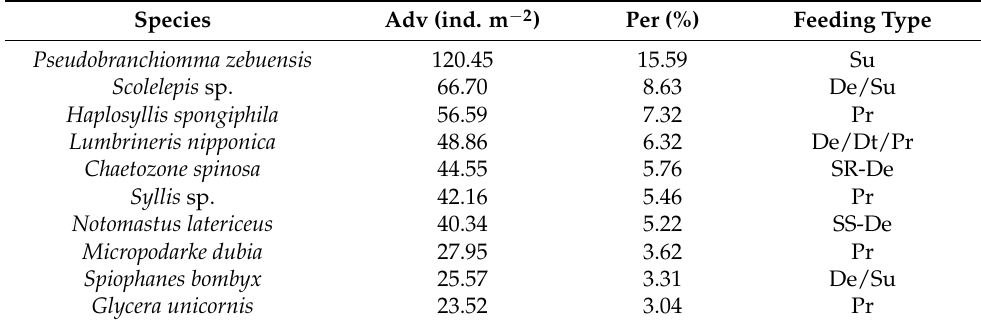
Table 3. Dominant polychaete species (>3%). Adv, average density; Per (%), percentage (%); SR-De, surface deposit feeder; SS-De, subsurface deposit feeder; Dt, detritus feeder; Su, suspension/filter feeder; Pr, predator. Species Adv (ind. m − 2 ) Per (%) Feeding Type Pseudobranchiomma zebuensis 120.45 15.59 Su Scolelepis sp. 66.70 8.63 De/Su Haplosyllis spongiphila 56.59 7.32 Pr Lumbrineris nipponica 48.86 6.32 De/Dt/Pr Chaetozone spinosa 44.55 5.76 SR-De Syllis sp. 42.16 5.46 Pr Notomastus latericeus 40.34 5.22 SS-De Micropodarke dubia 27.95 3.62 Pr Spiophanes bombyx 25.57 3.31 De/Su Glycera unicornis 23.52 3.04 Pr